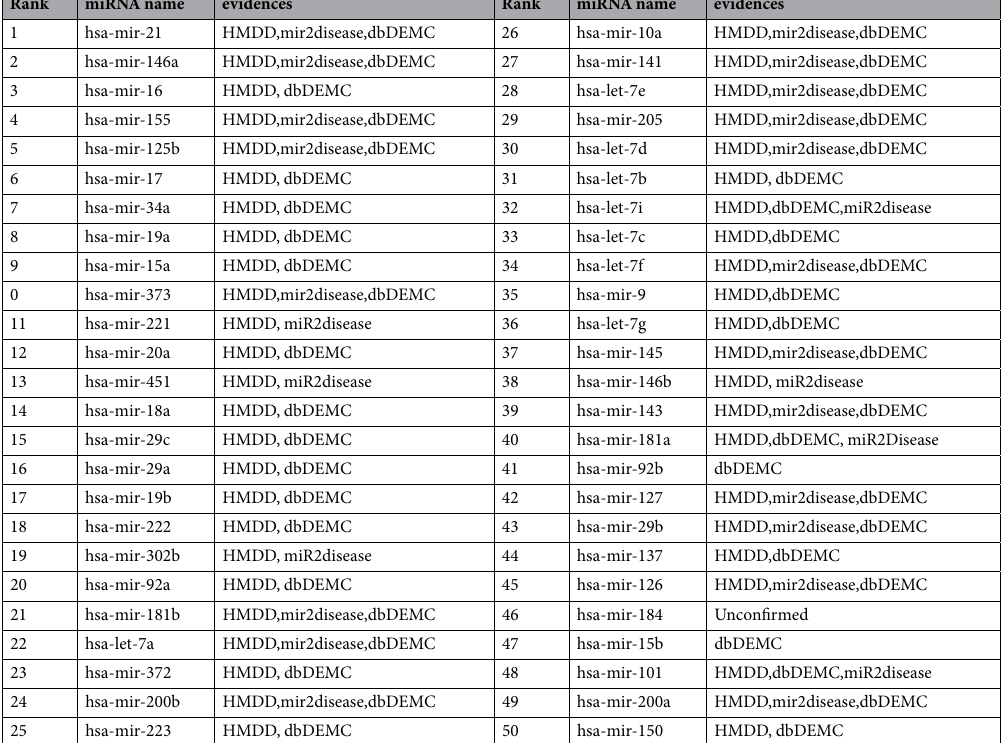
Table 3. The top 50 breast cancer-related miRNAs candidates predicted by GSTRW with removed all known breast cancer-miRNA associations and the confirmation of these associations. Forty-nine of the top 50 potential breast cancer miRNAs candidates have been confirmed based on the update HMDD, dbDEMC and